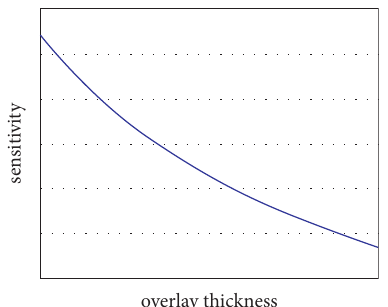
Figure 8: Sensitivity vs. overlay thickness.